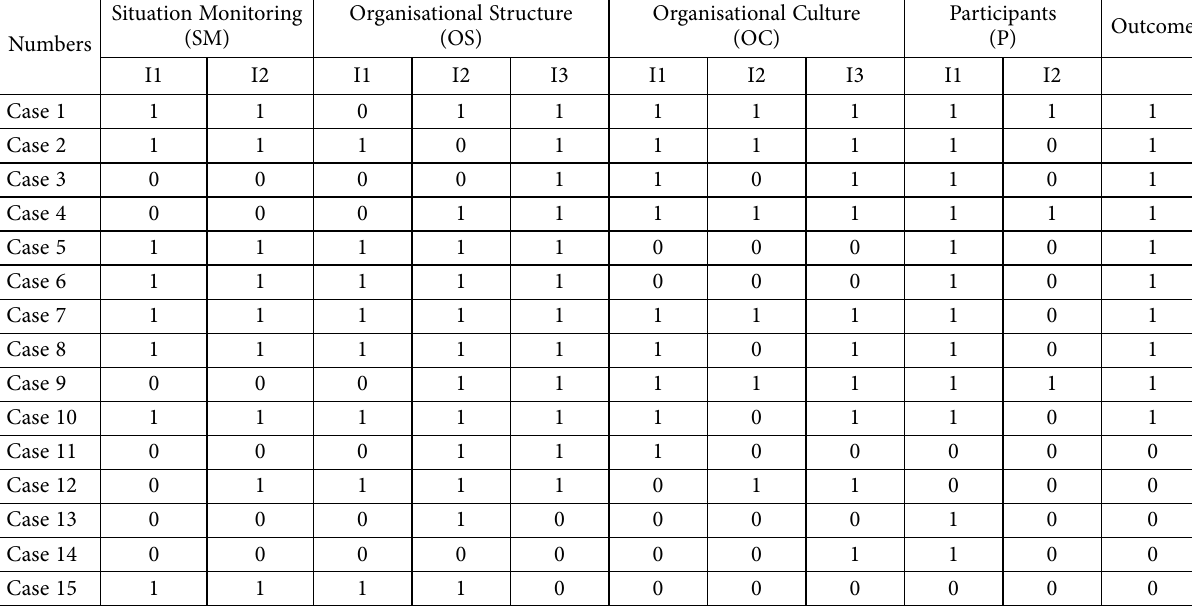
Table 4. Organisational resilience indicator results of each case